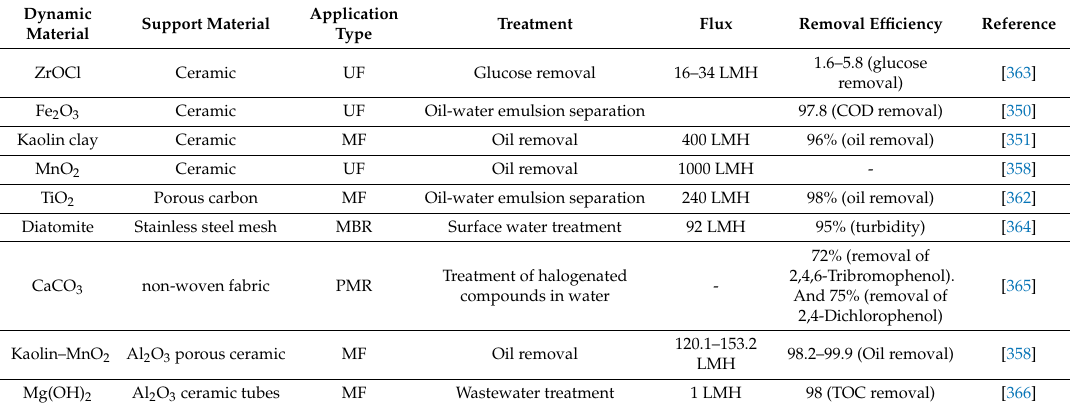
Table 8. List of different studies on different dynamic material layers for water treatment